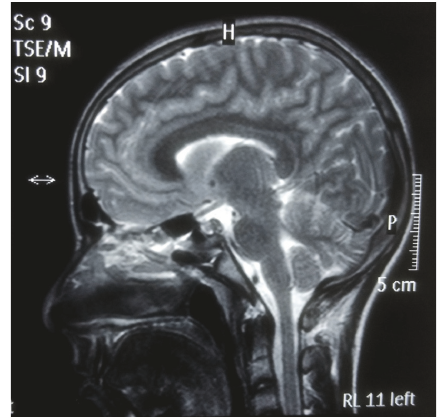
Figure 3: MRI head and orbit at the level of the midorbit and apex showing absence of any granulomatous lesions nor any extraocular muscle thickening (ruling out myositis or orbital pseudotumor).